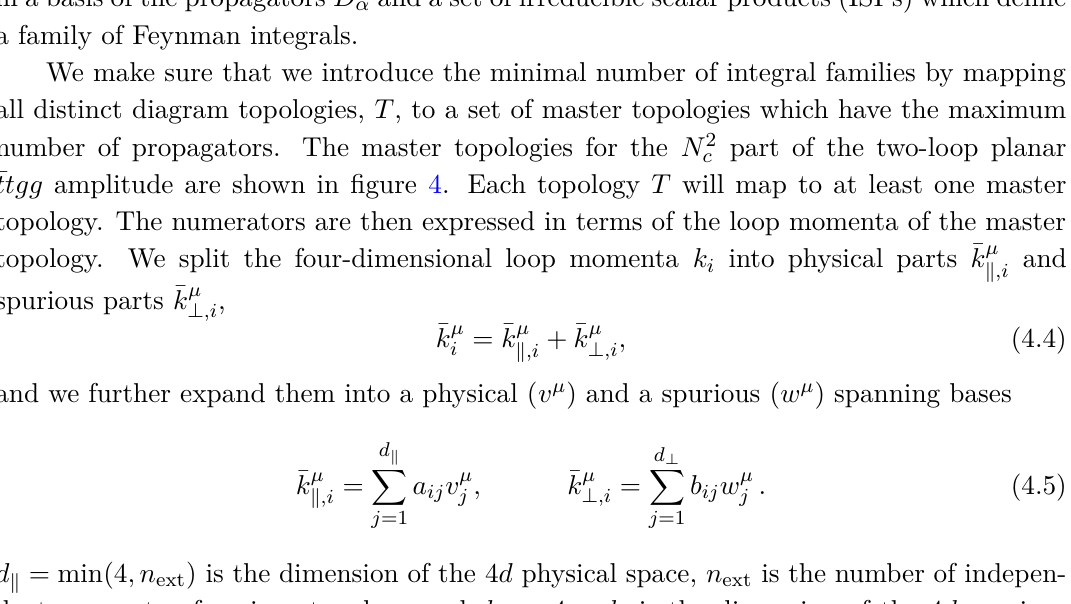
Figure 4. Maximal topologies for the N 2 represent top quarks, red-dashed lines represent